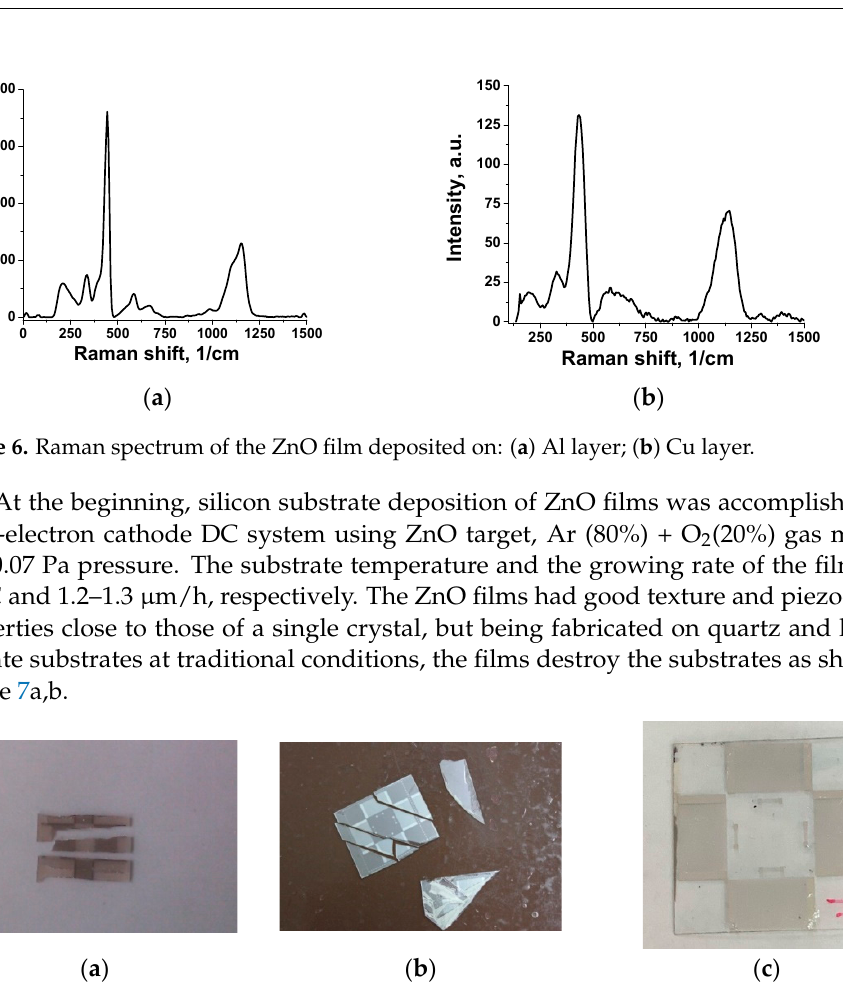
Figure 6. Raman spectrum of the ZnO film deposited on: ( a ) Al layer; ( b ) Cu layer.